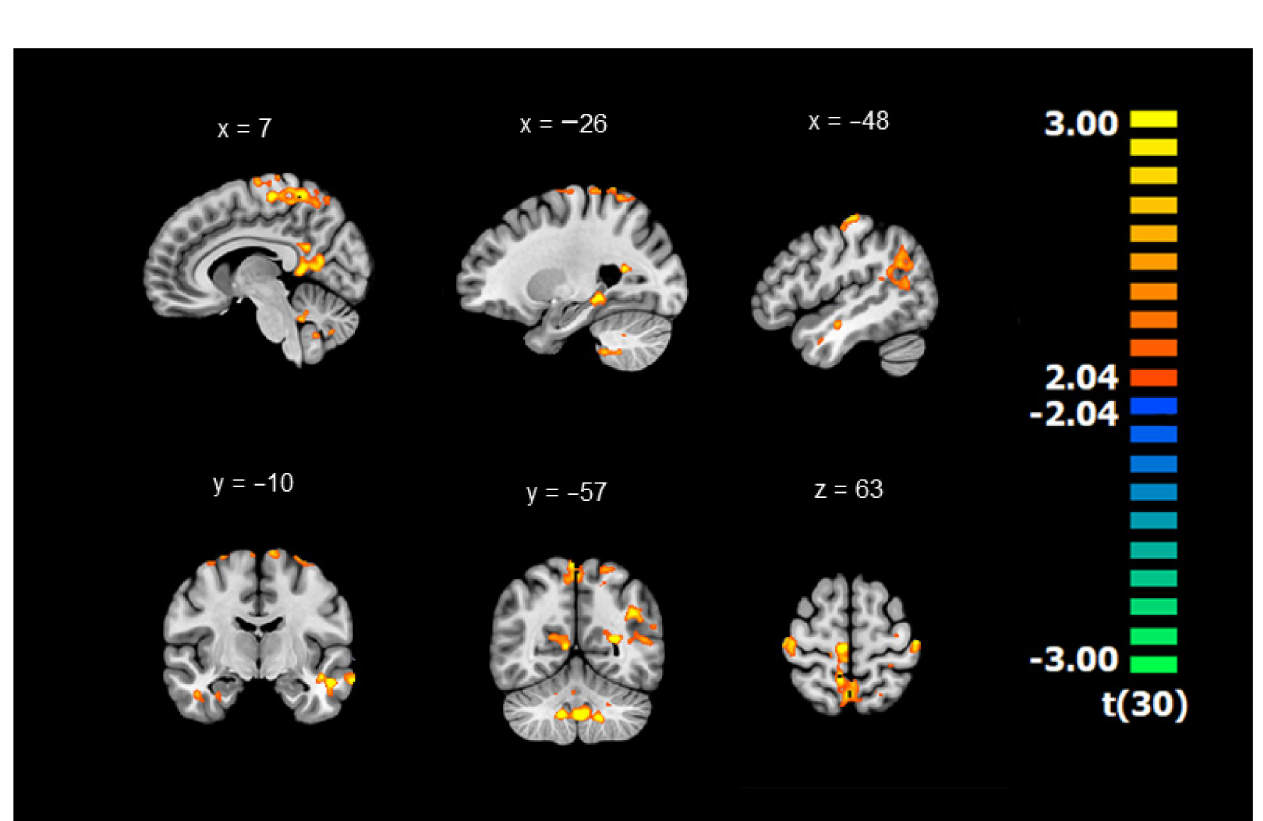
Figure A1. Visual representation of the clusters for which the GMFA seed region showed reduced RSFC in DYS compared to TD (whole-brain ANOVA, p < 0.05 corrected for multiple